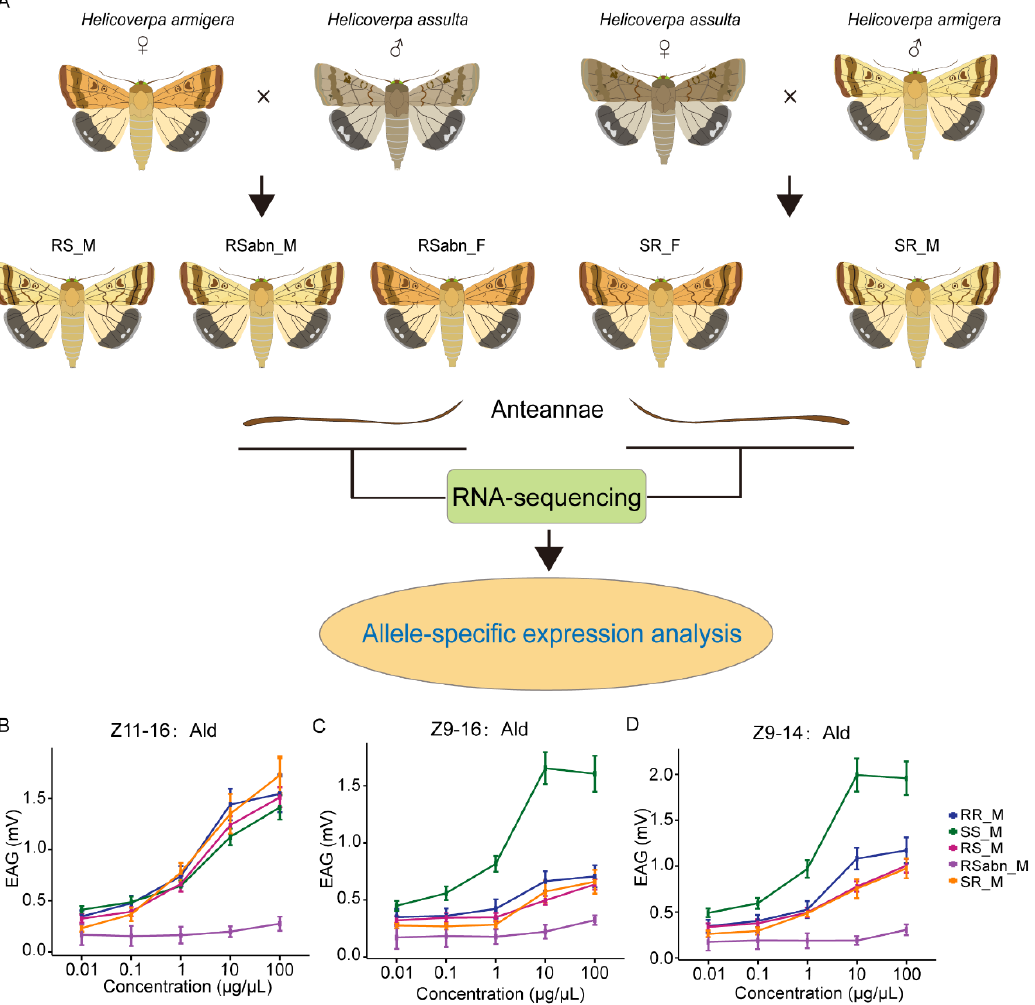
Figure 1. Interspecific hybridization and electrophysiological responses of H. armigera, H. assulta and F 1 hybrids. ( A ) The initial crosses employed female H. armigera (RR_F) as the female parent and male H. assulta (SS_M) as the male parent, which produced three groups of F 1 hybrids, comprising fertile males (RS_M), sterile abnormal males (RSabn_M) and sterile abnormal females (RSabn_F). The reciprocal crosses employed female H. assulta (SS_F) as the female parent and male H. armigera (RR_M) as the male parent, which produced two groups of F 1 hybrids, comprising fertile males (SR_M) and fertile females (SR_F). The antennae of the parents and their F 1 hybrids adults were used for transcriptome sequencing, and then ASE analysis was performed. ( B – D ) The dose-EAG responses of RR_M, SS_M, RS_M, RSabn_M and SR_M to Z11-16:Ald ( B ), Z9-16:Ald ( C ), and Z9-14:Ald ( D ).